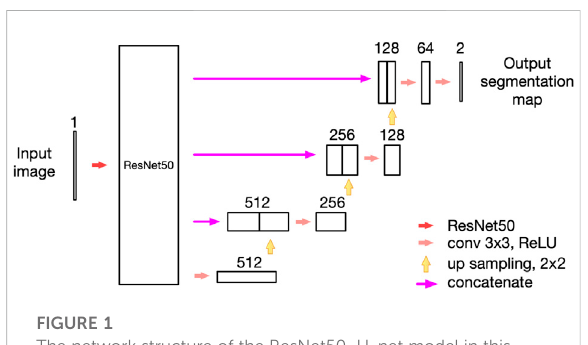
FIGURE 1 The network structure of the ResNet50_U-net model in this